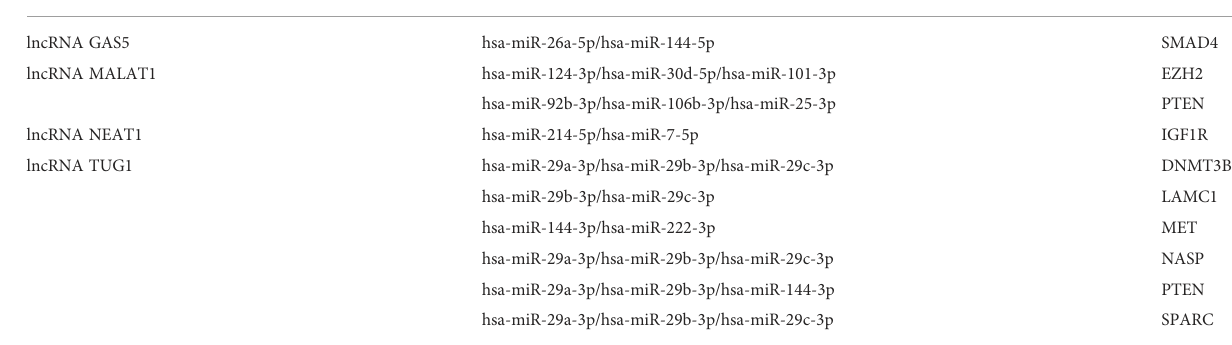
TABLE 4 Predicting the role of lncRNA-miRNA-mRNA in COVID-19.